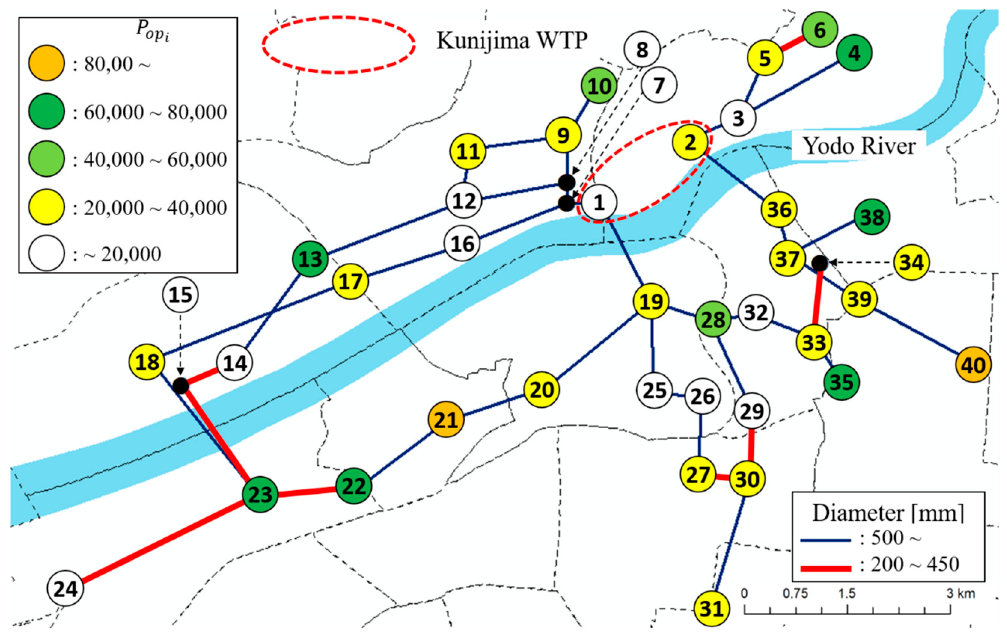
Figure 3. Image of the Kunijima water treatment plant (WTP) network created according to the 100-year history of Osaka City Waterworks Bureau (1996) [32]. The color of each node and pipeline represents the population size and pipeline diameter, respectively.